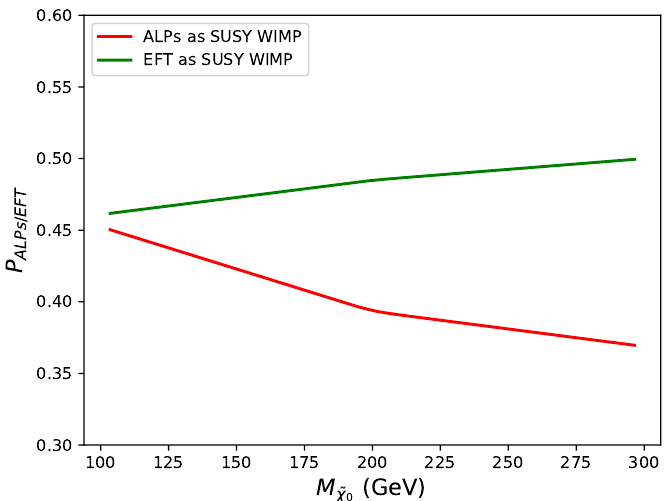
Figure 6: Probability of misidentifying ALPs or EFT DM scenarios with a true SUSY WIMP as a function of the neutralino mass.